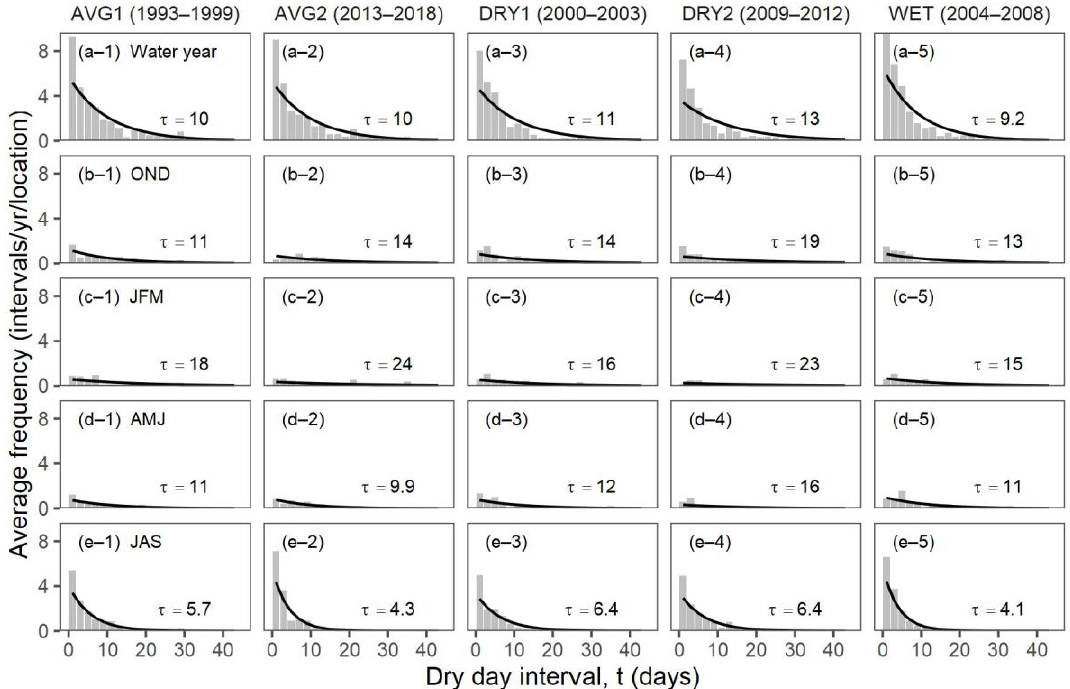
Figure 5. Dry-day interval sample distributions (bars; number of intervals/yr/location) and fitted exponential PDFs (curves) <45 days with a bin size of 2 days. Relative frequency for each season and period was calculated using bin frequencies from all 16 locations, number of years in the period divided by 16 and the number of years. PDF curves (probability density) are vertically-scaled to match the average frequencies. Row ( a ) is water year, row ( b ) is fall, row ( c ) is winter, row ( d ) is spring, and row ( e ) is summer.